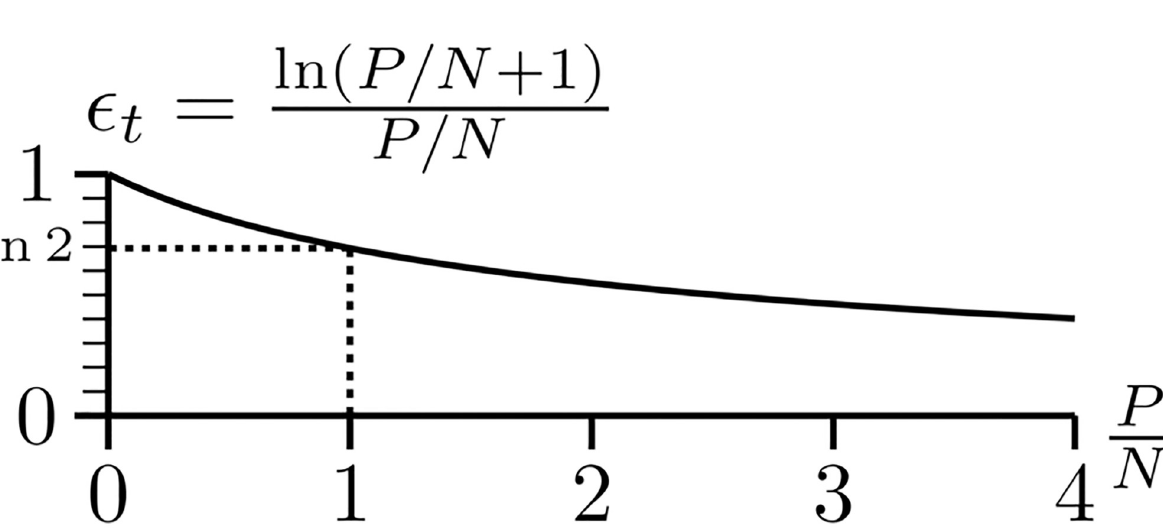
PLOS ONE | https://doi.org/10.1371/journal.pone.0279758 January 10,